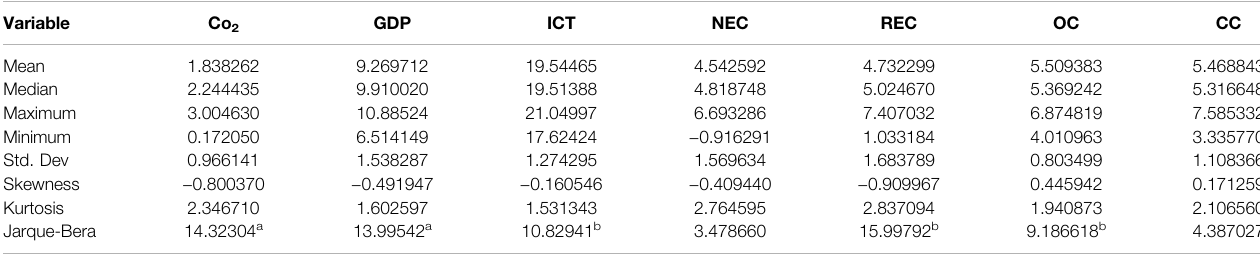
TABLE 3 | Descriptive statistics.